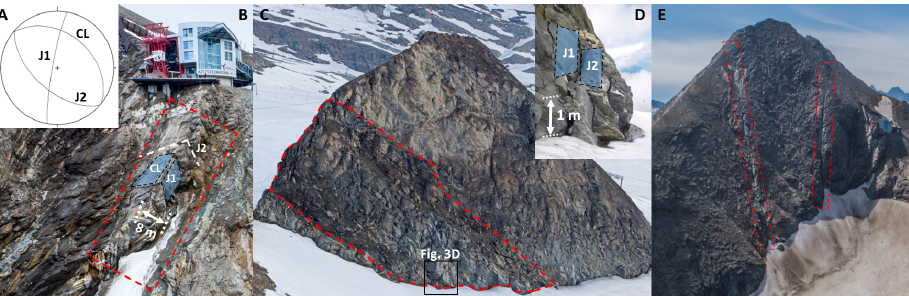
Figure 3. Geological structure and weakness zones at the monitored rockwalls: (a) cleavage (CL) of the calcareous mica schists dips about 45 ◦ NNE. Joint sets J1 (dipping subvertical to W) and J2 (dipping steeply to SW) are approximately orthogonal to CL and predispose north-facing slopes for dip-slope failures; (b) highly fractured, slope-parallel escarpment at KN (photo: Robert Delleske, 1 August 2018); (c) diagonal weakness zone following the direction of cleavage at MKE (photo: Robert Delleske, 18 July 2014); (d) steep joint sets (J1, J2) predispose east- and west-facing areas to toppling failures (photo: Andreas Schober, 28 July 2010); (e) prominent fault lines resulting from ductile shearing at KNW (photo: Robert Delleske, 27 August